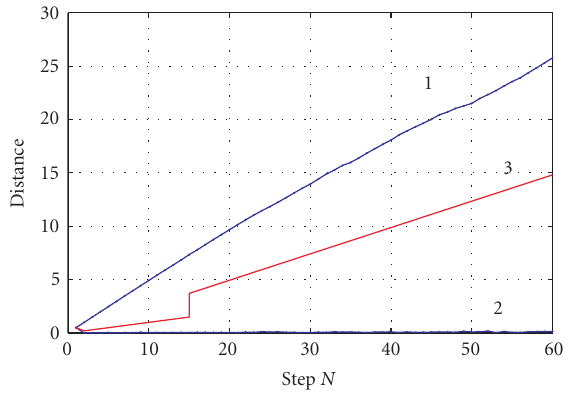
Figure 4: An experimental way to determine n : the relationships between D and n in di ff erent conditions. n denotes the number of steps a photon travels, and D denotes the distance between the po- sition of the photon and the nearest media boundary. The range of a single step is constrained to 5, so line 1 begins at D =